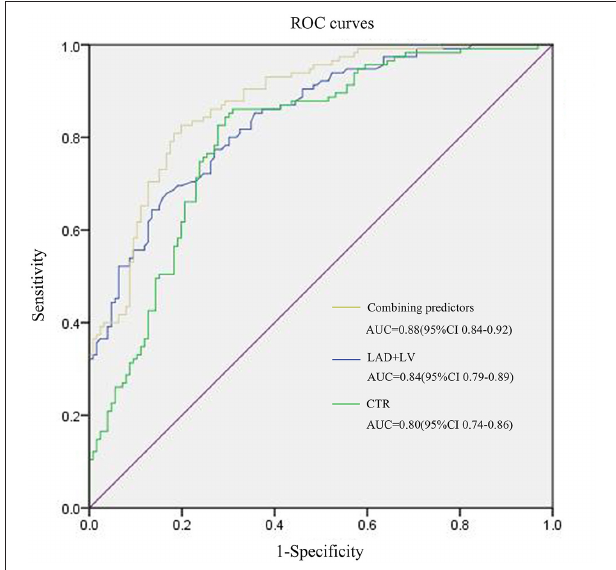
FIGURE 4 | ROC curves for MACE prediction of patients with COVID-19. LAD, The anteroposterior diameter of the left atrium; LV, The length of the left ventricle; CTR, cardiothoracic ratio.